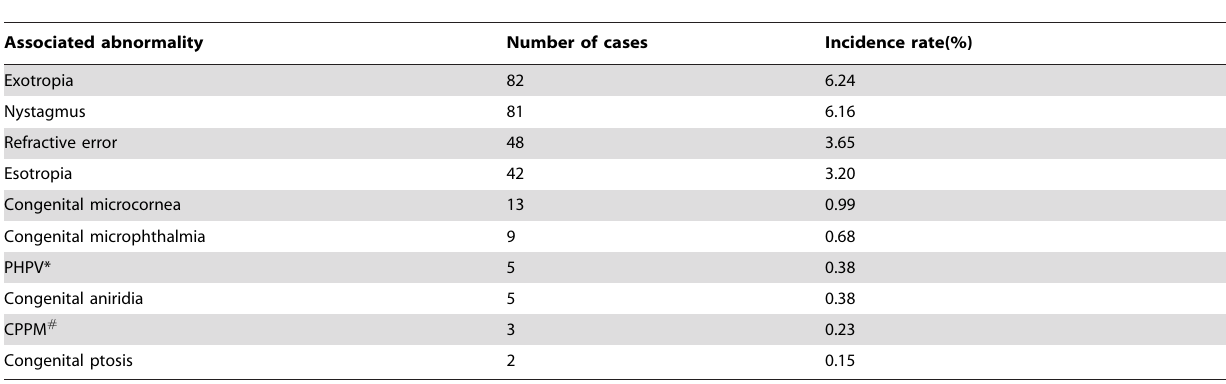
Table 1. Associated ocular abnormalities and their